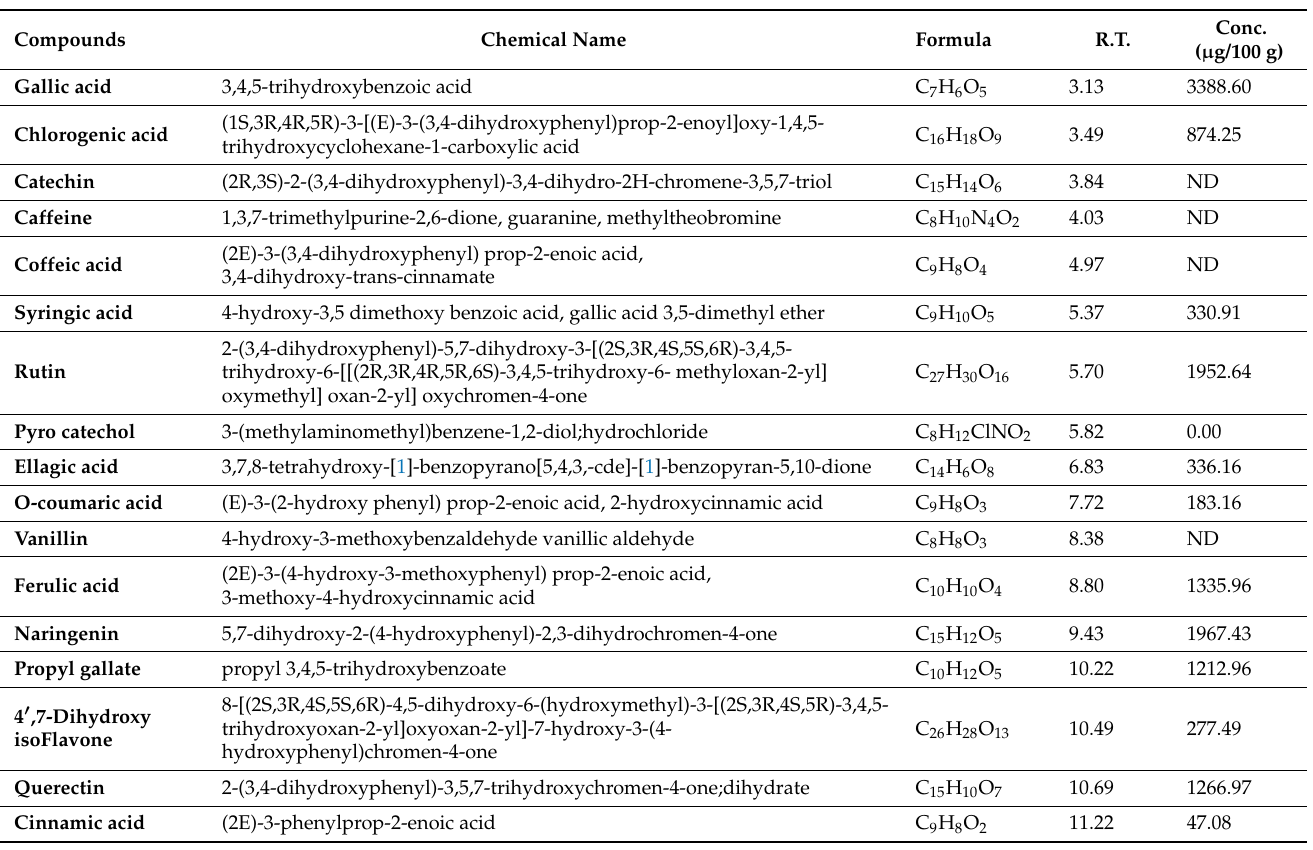
Table 2. Phenolic compounds identified by high-performance liquid chromatography (HPLC) ( µ g/g) OPE.